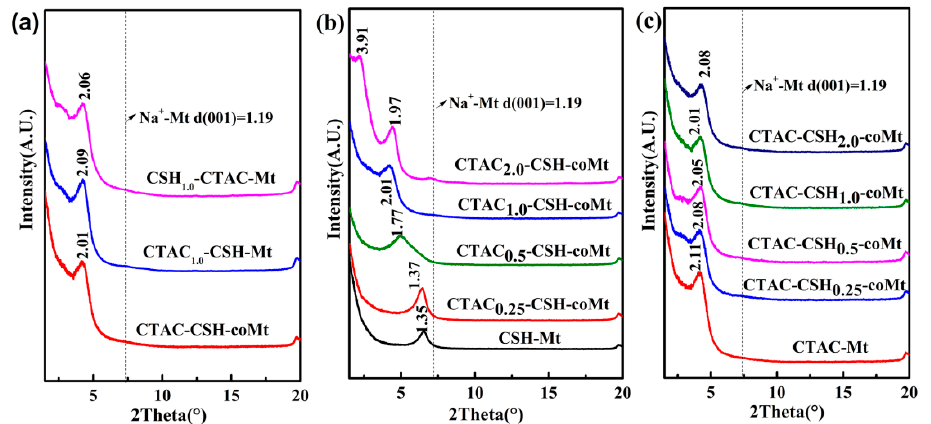
Figure 6. X-ray diffraction (XRD) patterns of OMt obtained under three different preparation methods: different order of addition using the same amount of CTAC and CSH ( a ), with different amounts of CTAC ( b ) and CSH ( c ).